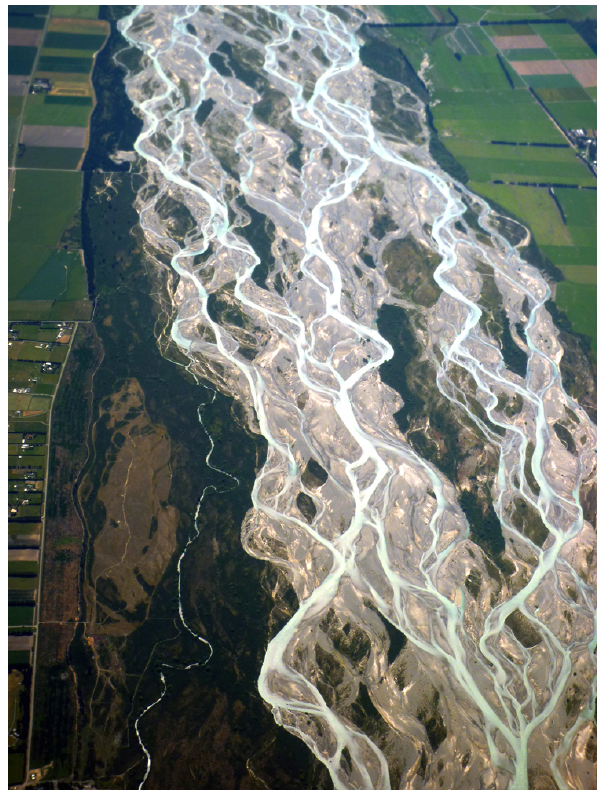
Figure 2. Rakaia River in New Zealand displaying a classic braided pattern. Image reproduced with permission by Andrew Cooper.